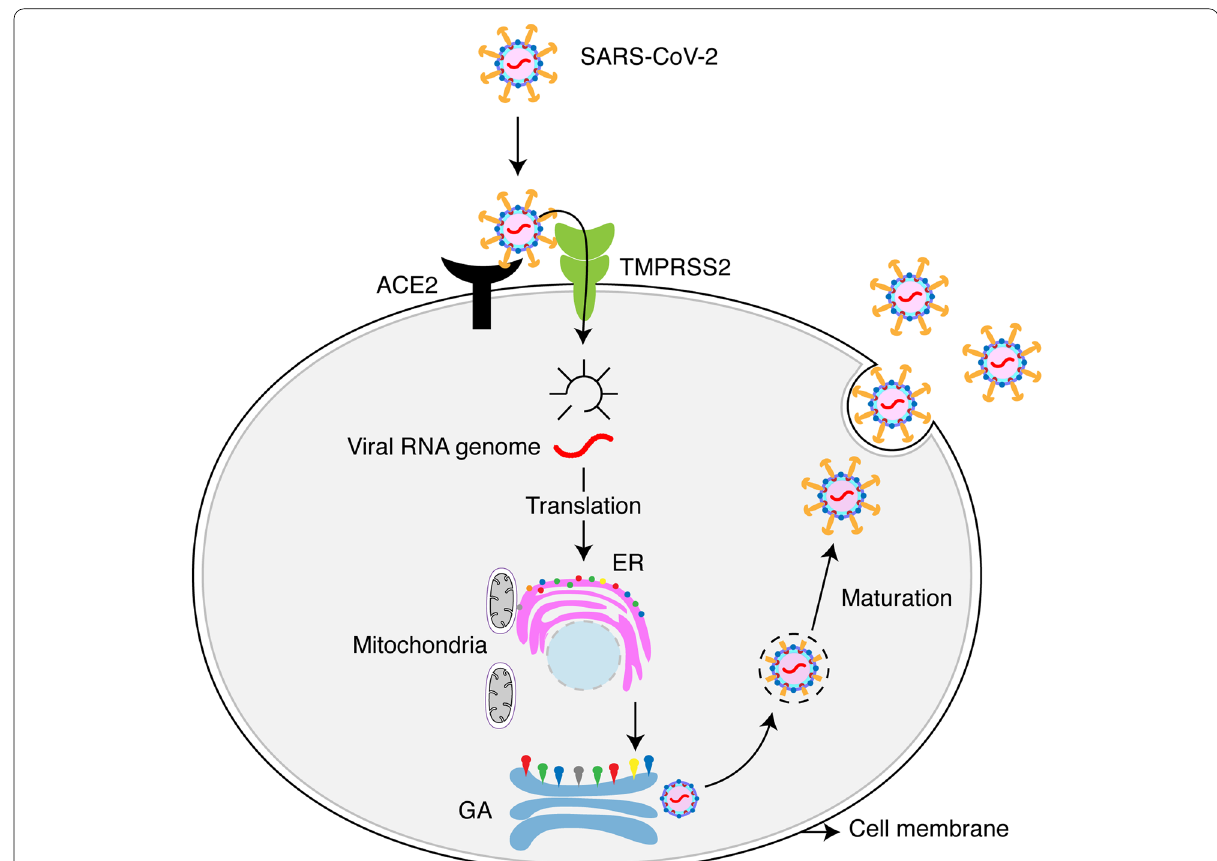
Fig. 2 Schematic representation of SARS-CoV-2 entry and replication in host cells. SARS-CoV-2 enters host cells through its spike ‘S’ protein by interacting with the host’s ACE-2 receptor, where S is primed by the host cell serine protease, TMPRSS2. Upon entry, the release of viral genomic RNA subsequently leads to genomic replication using the host cell’s translational and transcriptional machinery. Structural proteins are synthesized and assembled at the Endoplasmic reticulum (ER) and Golgi apparatus (GA), respectively, following their maturation and